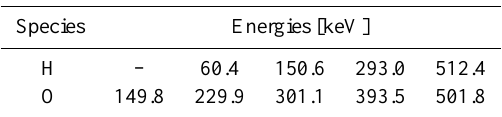
Table 1. Energies of H and O neutral atoms used in the NUADU calibration.